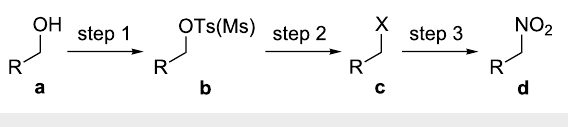
Figure 1: Classical conversion of tosylate and mesylate into the corresponding nitroalkanes via halides.